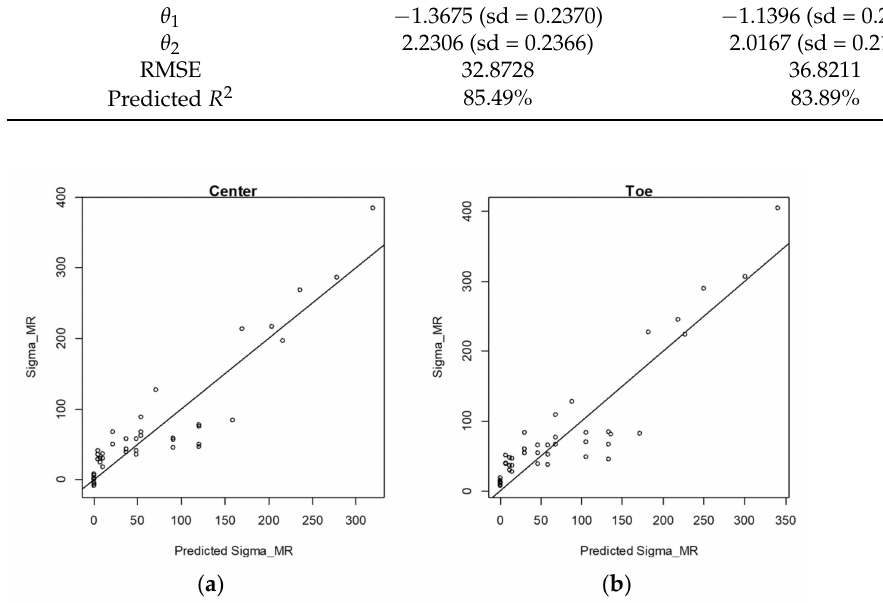
Table 5. Estimation results of σ MR prediction model and model performance measures. Position